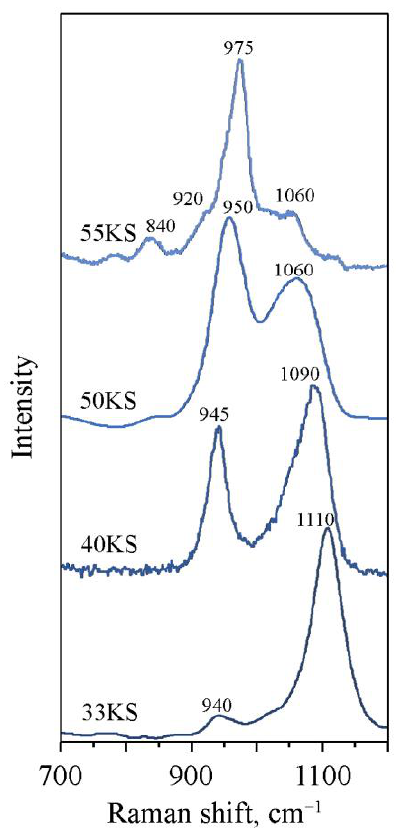
Figure 1. Raman spectra of the K 2 O-SiO 2 glasses with 30, 40, 50 and 55 mol.% K 2 O.